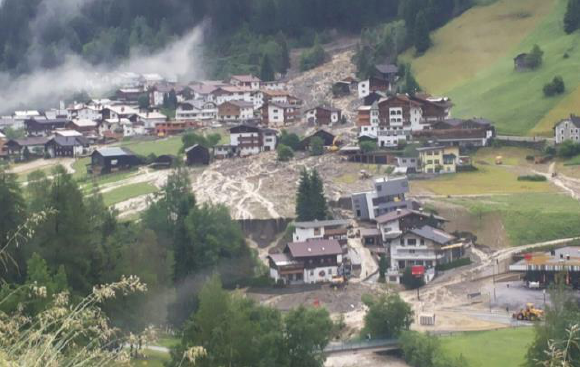
Figure 7. Landslide at See / Paznauntal, © Florian Leitner